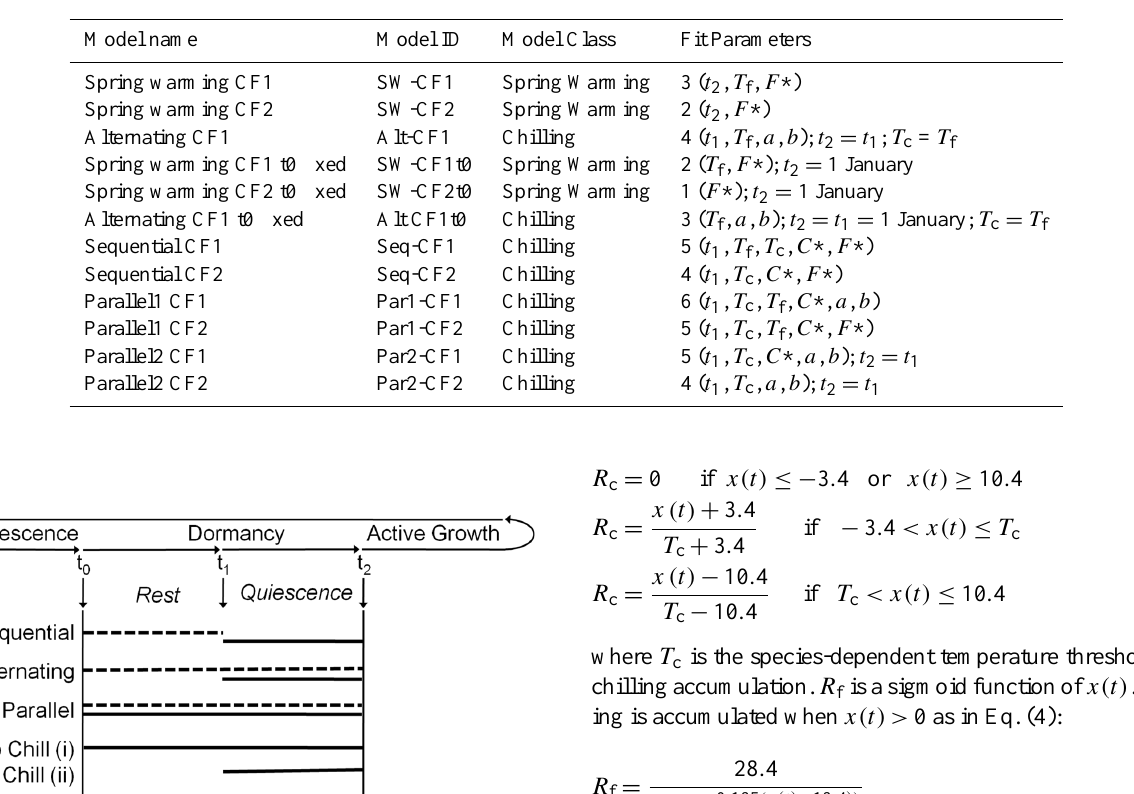
Table 2. List of phenology models fit to Harvard Forest phenology data, model identifier (Model ID), models class (chilling models or spring warming models) and fit parameters (number and variables symbols). Spring warming, sequential, alternating and parallel model structures are described in text and in Fig. 2. CF1 and CF2 refer to different functional forms for forcing and chilling rates, as described in text. t 1 : time step at which accumulation of chilling units begins (not used in spring warming models; fit parameter in all other models). C *: chilling state at which transition from rest to quiescence occurs (fit parameter in sequential and parallel 1 models; not used in other models). t 2 : time step at which accumulation of forcing units begins (fit parameter in spring warming models; equal to t 1 in alternating and parallel 2 models; date when cumulative chilling ( S c ) is equal to C * in sequential and parallel1 models). F *: forcing state at which transition from quiescence to bud-burst occurs (fit parameter in spring warming and sequential models; function of S c in alternating, parallel 1 and parallel 2 models). T c : critical temperature for chilling function R c (t) (not used in spring warming models; fit parameter in all other models). T f critical temperature for forcing function R f (t) (fit parameter in all models). a , b model constants ( a > 0, b < 0) relating F * to S c , i.e. F * = a exp (bS c (t) ) at t = y . y is the predicted bud-burst date ( a , b not used in spring warming, alternating or sequential models; fit parameter in all other models).